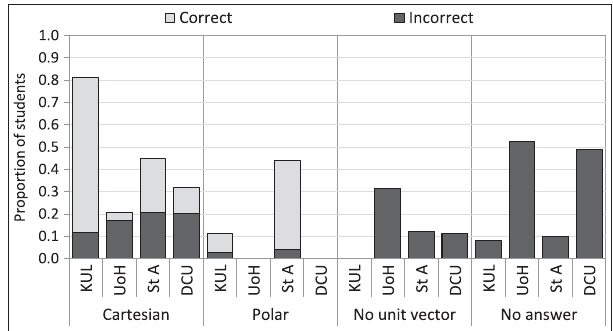
FIG. 11. Proportion of correct responses, depending on the chosen coordinate system, to question 2(b) [Fig. 1(b)].